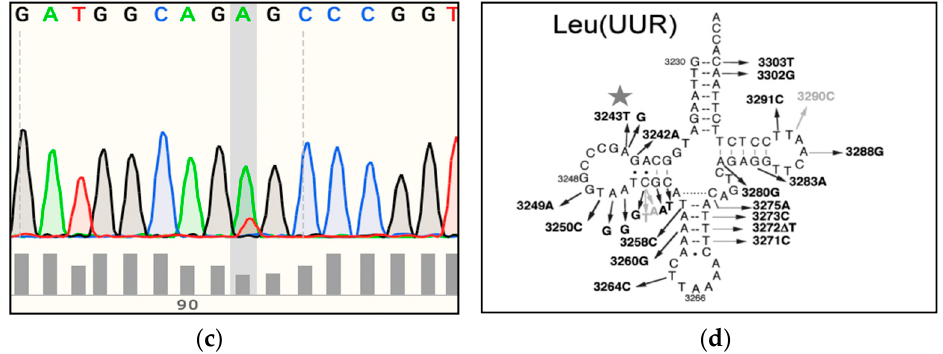
Figure 1. GS detects low levels of heteroplasmy in blood of P1. ( a ) Integrative Genomics Viewer (IGV) browser shows the identification of m.3243A>T in blood. The black arrow points to the variant (in red) present in 79 of 4235 reads aligned to the m.3243 position. ( b ) Partial electropherogram showing the heteroplasmic m.3243A>T variant detected in urine. ( c ) IGV browser shows the identification of m.3243A>T in muscle, the variant (in red) is present in 6108 of 8799 reads aligned to the m.3243 position. ( d ) Mamit-tRNA [38] schematic of the mt-tRNA Leu(UUR) cloverleaf secondary structure showing in black positions of reported pathogenic variants. The m.3243A>T variant found in P1 is highlighted with a star and is located in the D-loop of the mt-tRNA Leu(UUR) . In silico software predicted this variant to be disease-causing. (Table 1). The variant was not detected in 56,423 individuals reported in the gnomAD v3.1 database [39]. Table 1. Pathogenicity predictions of the NC_012920.1( MT-TL1 ):m.3243A>T variant in P1. In Silico Tool Prediction (Score) Reference